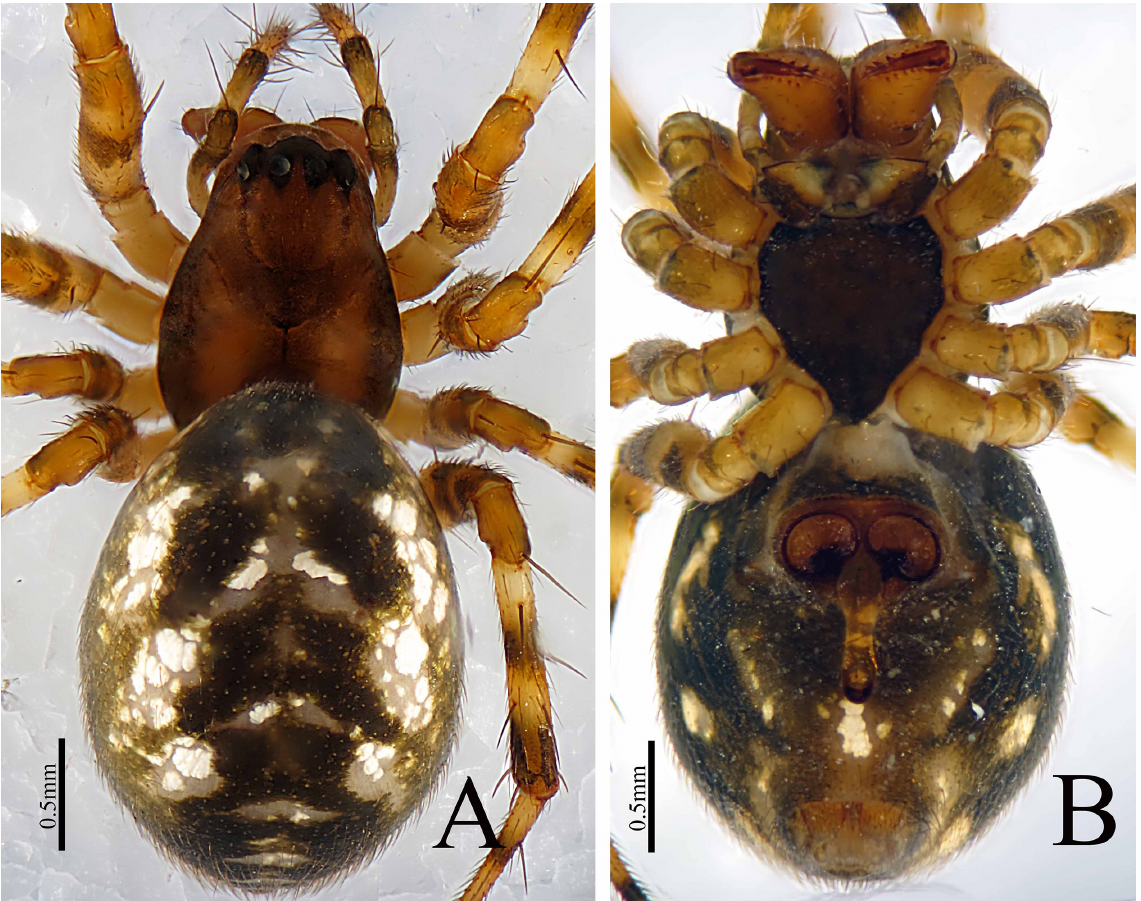
Fig. 35. Acroterius ovatus gen. et sp. nov., ♀, holotype (HNU-YHY06). A . Habitus, dorsal view. B . Habitus, ventral